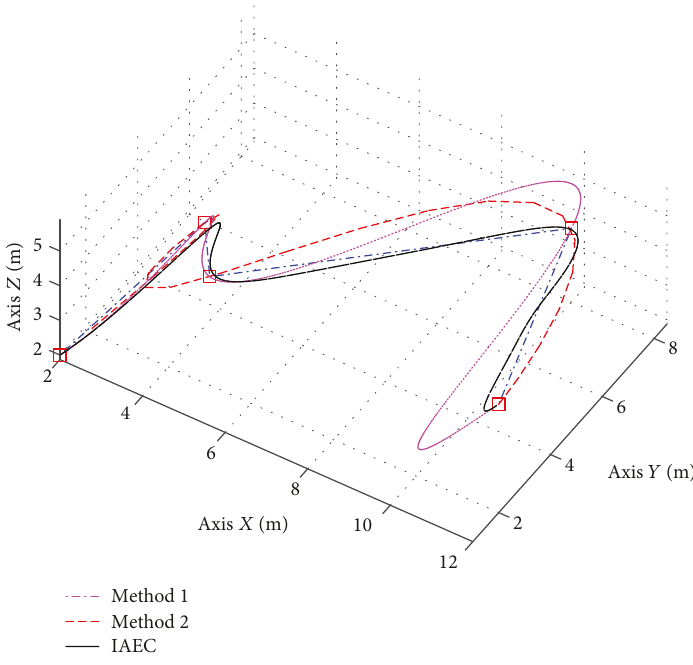
Figure 9: Trajectory planning Table 2: Landing comparison experiment results (20 experiments).